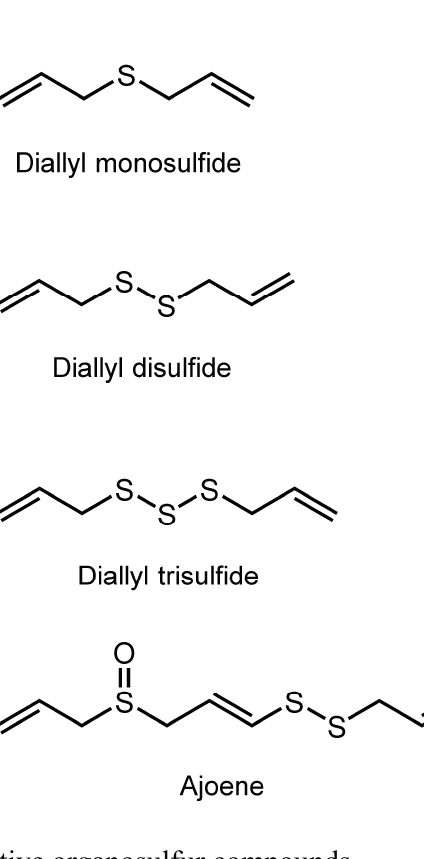
Figure 6. Structures of membrane-interactive organosulfur